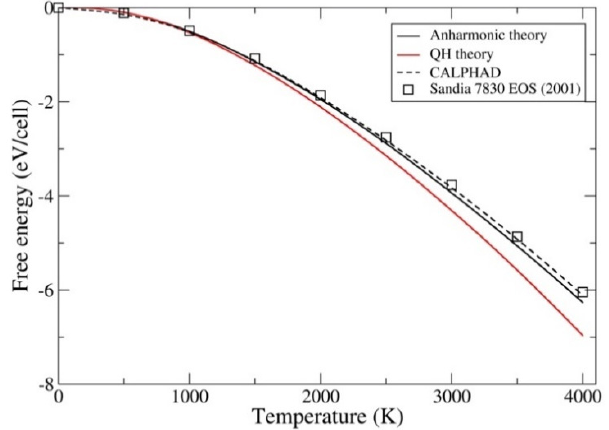
Figure 3. Anharmonic (black line), quasi-harmonic (QH) (red line), CALPHAD [32] (dashed line) and Sandia EOS model [33] (open squares) free energies for graphite.